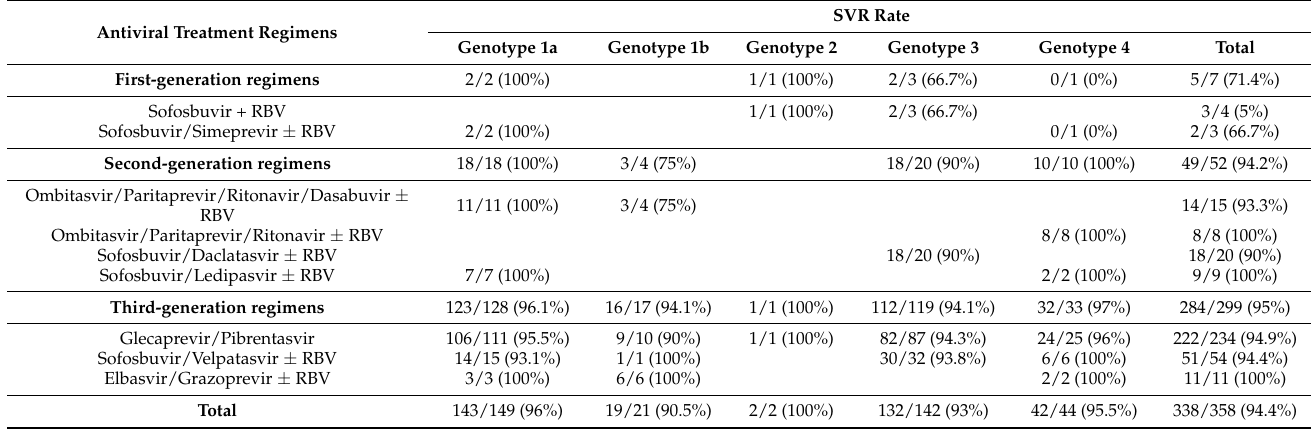
Table 2. Intention-to-treat SVR rate according to genotypes and antiviral treatment